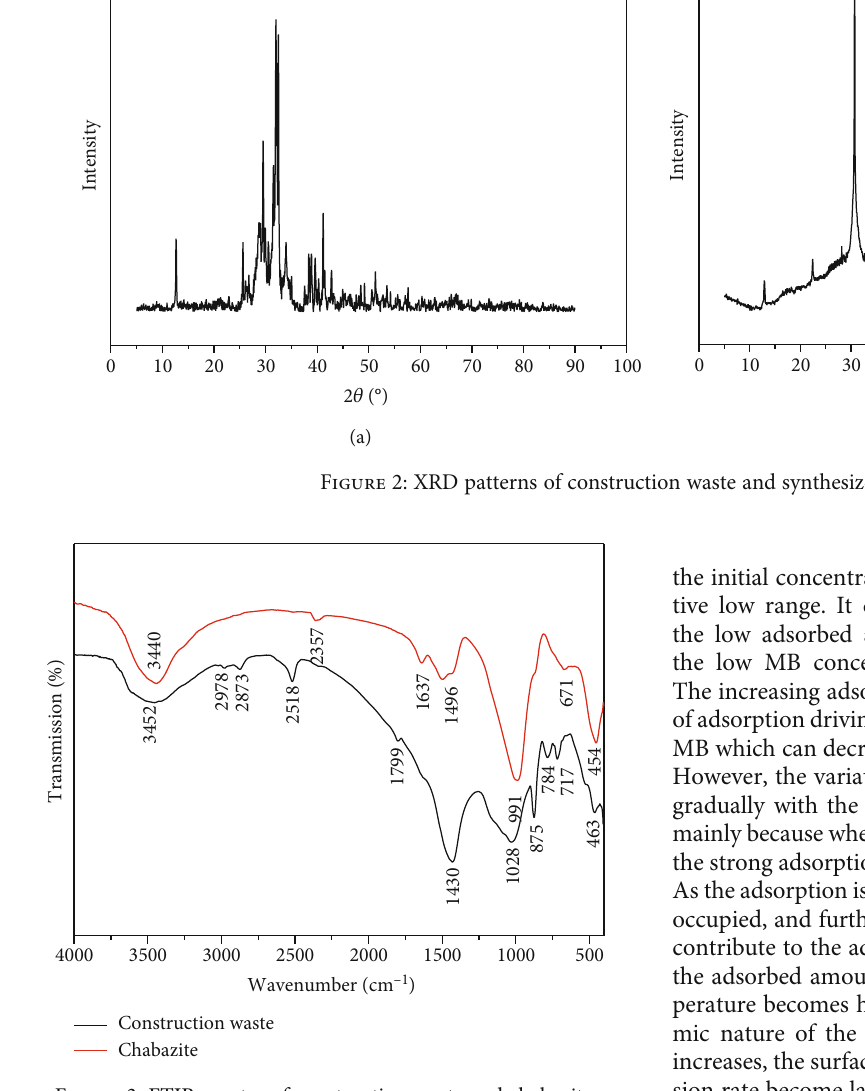
Figure 3: FTIR spectra of construction waste and